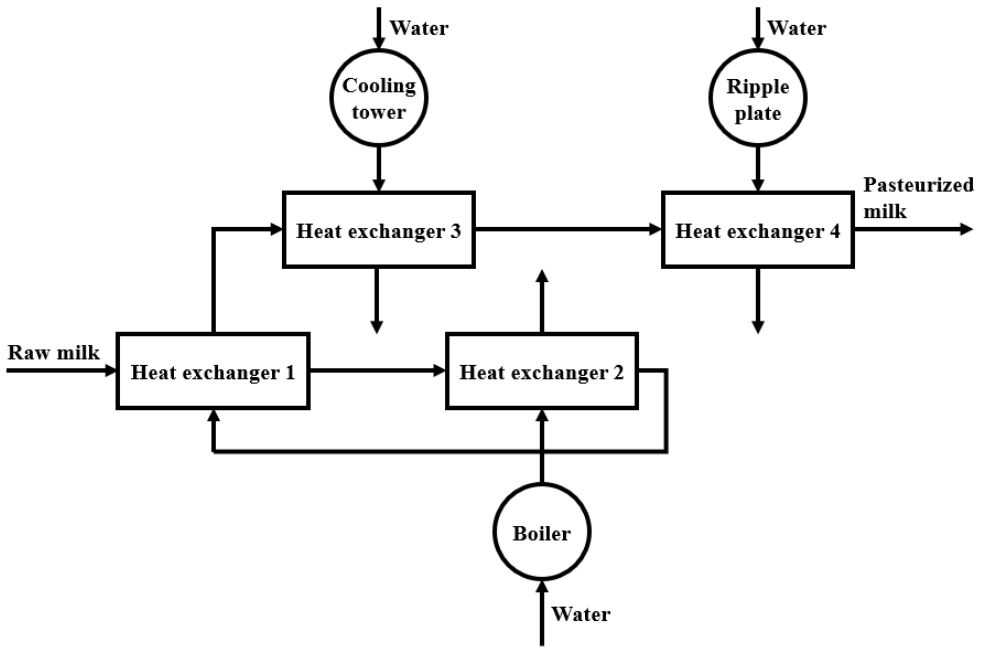
Figure 1. Schematic flow diagram for the pasteurization process considered.